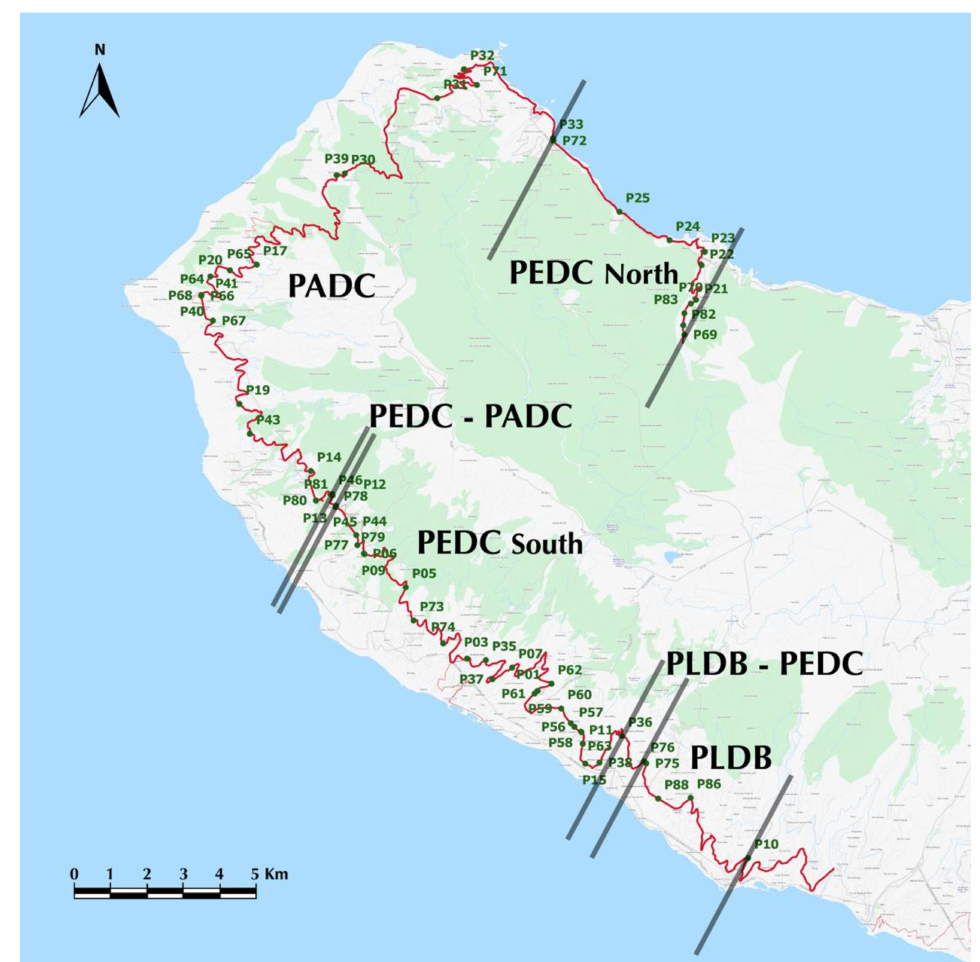
Figure 1. Location of sampling sites (dark green dots) orthogonally projected on the roads ER222 and ER101 (red line) of Madeira. See Table S1 for details on sampling sites. Black lines represent the limits of di ff erent chromosomal zones, PLDB represents the Lugar de Baixo race, PLDB-PEDC the contact zone between the Lugar de Baixo and Estreito da Calheta races, PEDC the Estreito da Calheta race, PEDC-PADC the contact zone between the Estreito da Calheta and Achadas da Cruz races and PADC the Achadas da Cruz